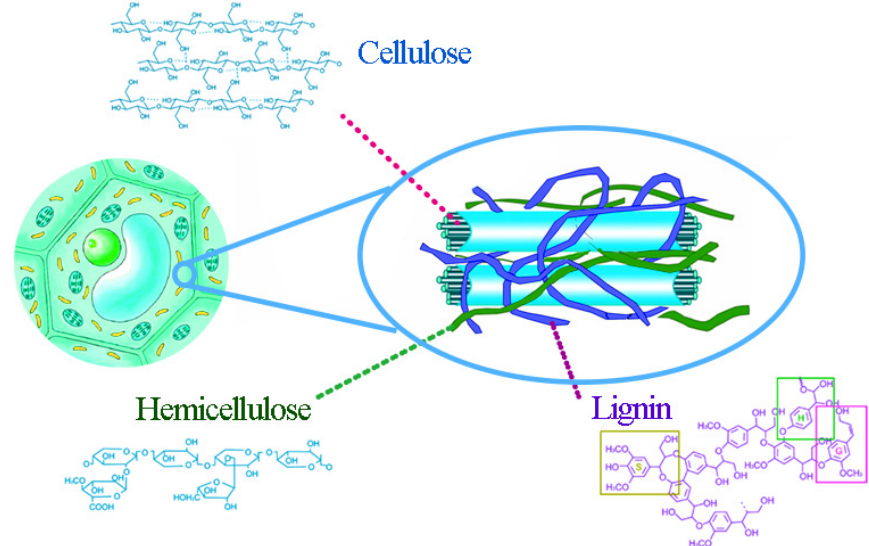
Figure 1. Cellulose chains surrounded by hemicellulose and lignin; adapted from [7]. Cellulose is a water-insoluble chain polymer composed of glucose groups linked by β -1,4-glycosidic, and its degree of polymerization is up to 10,000. Hydroxyl groups of each glucose unit are more than sufficient to form interchain and intrachain hydrogen bonds, stabilize the molecular structure itself, and connect with adjacent molecules to form microfibrils [8]. A large number of intermolecular and intramolecular hydrogen bonds from intertwining of crystalline and non-crystalline regions, form the two-phase structure of cel- The crystallization degree of cellulose shows different enzymatic hydrolysis